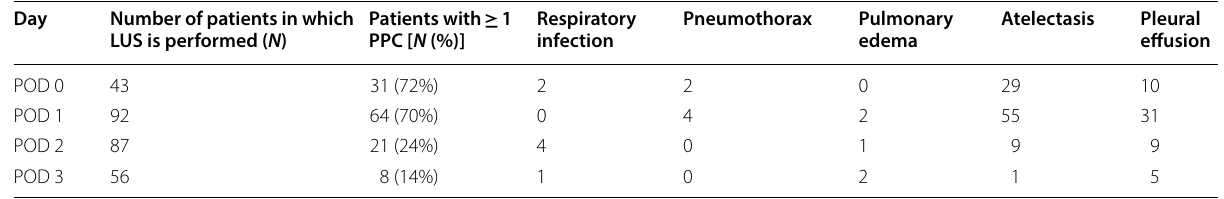
Patients can develop multiple PPCs. Total amount of PPCs can be higher than the number of patients